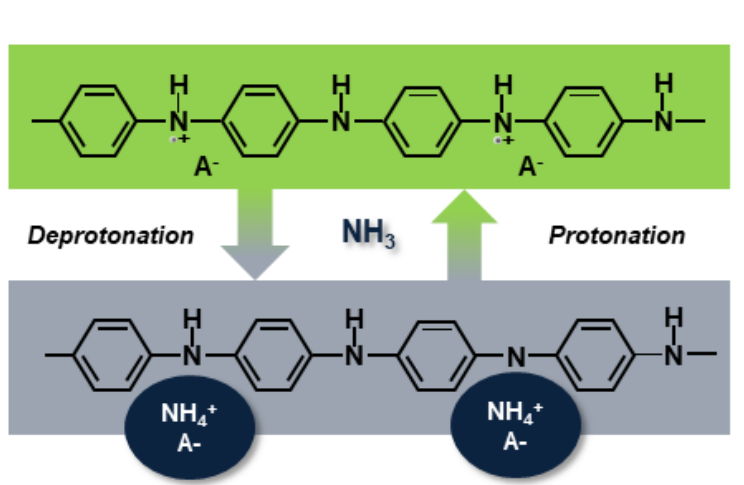
Figure 10. Mechanism of deprotonation/protonation at the origin of the PANI’s sensitivity to am- monia gas. A − , NH 3 and NH 4+ refer to the dopant, ammonia and ammonium cation,